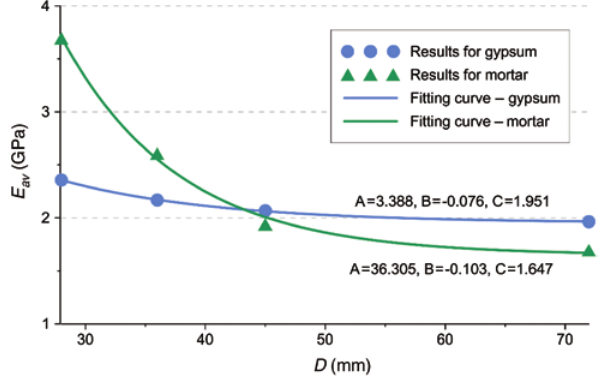
as a function of the specimen av